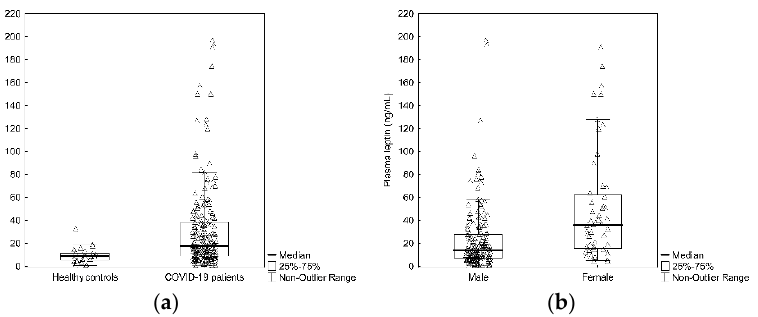
Figure 1. ( a ) Plasma leptin levels in ICU treated patients with COVID-19 vs. healthy controls ( p < 0.001). ( b ) Difference in plasma leptin levels in ICU treated patients with COVID-19 based on gender ( p < 0.001).